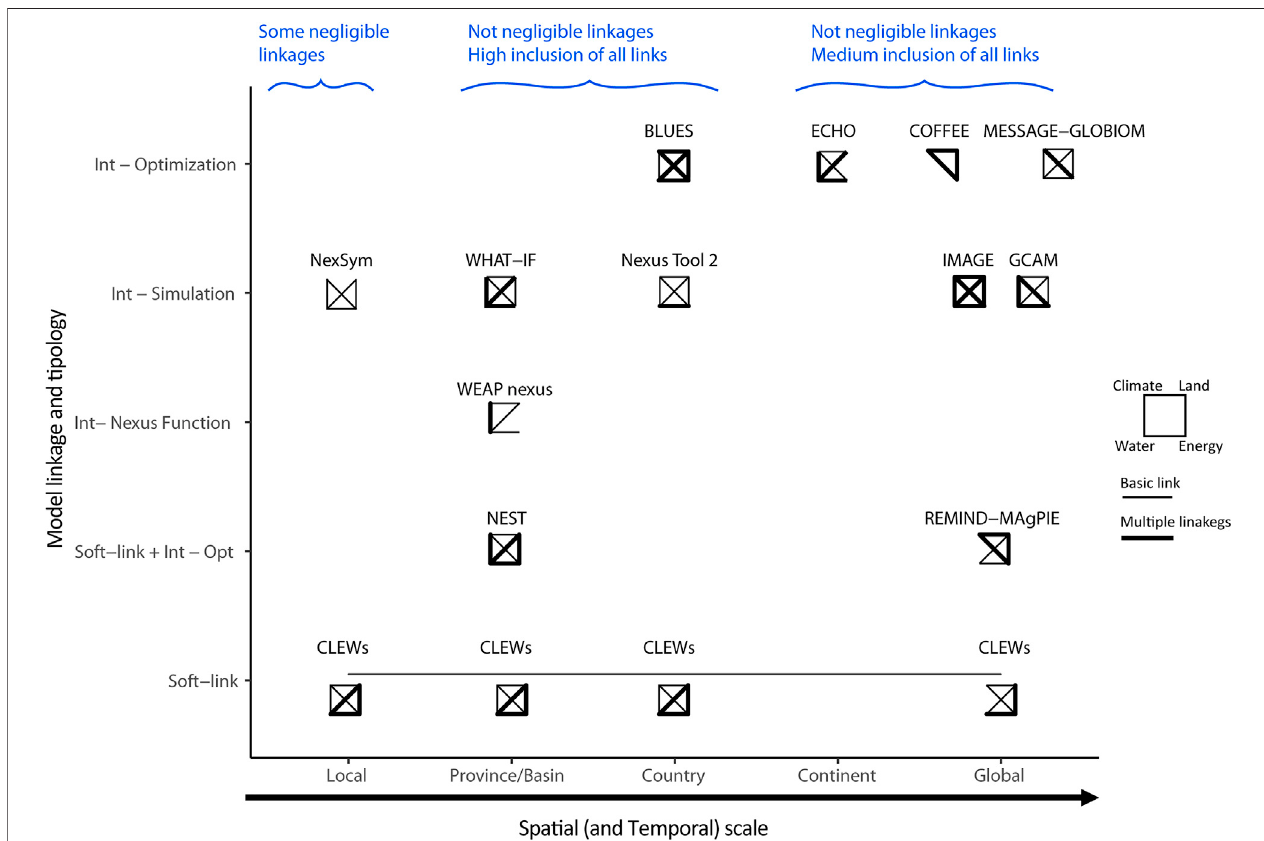
FIGURE2| IncreasingscaleoftheCLEWmodelconsideredandstructureandnexusintegration.Methodsdistinguishbetweensoft-linkedandintegratedmodules and simulation and optimization models. The squared symbols represent the interlinkages between climate, land, energy and water sectors, as displayed on the right panel (more detail in Supplementary Table S3